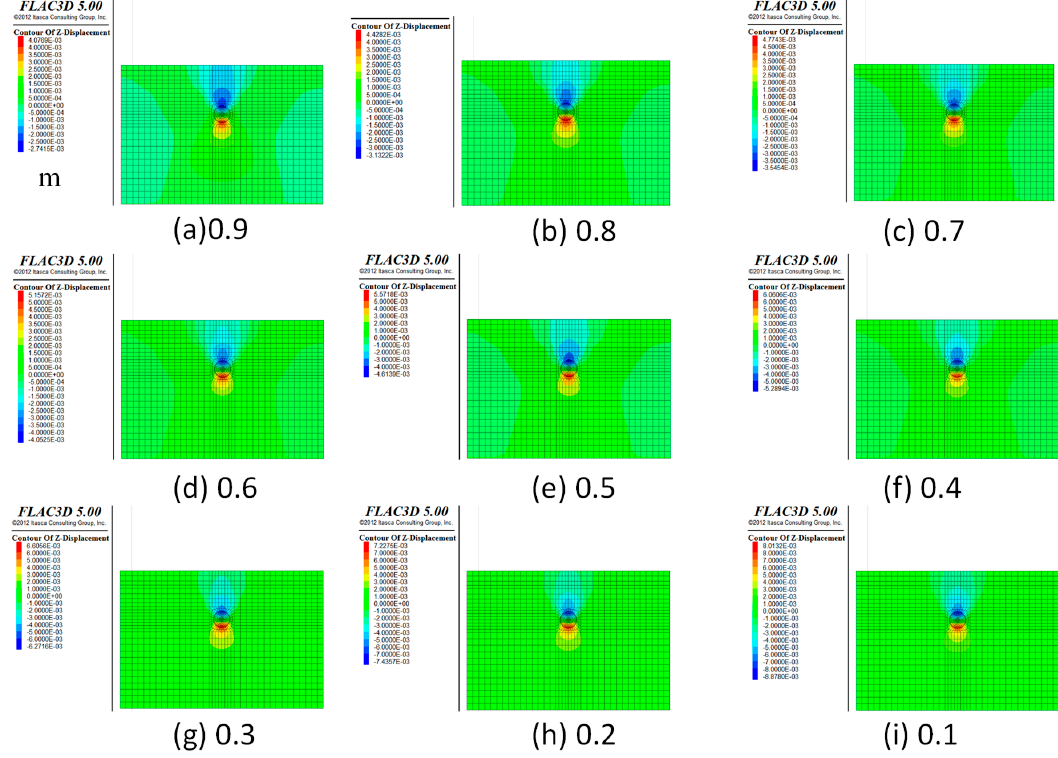
Figure 12. Vertical displacement cloud diagram of excavation face under various conditions of Section 3. (The numerical value in the figure represents the support pressure coefficient).